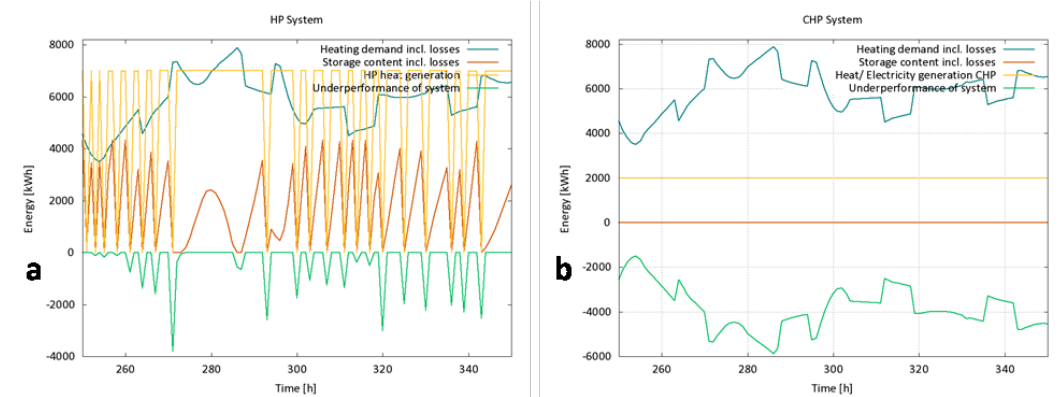
Figure 13. Analysis of the performance of both systems from the hours of the year 250 to 350, which include the peak heat demand (( a ): HP system, ( b ): CHP system). In Figure 14, 100 h in mid-October are shown for both systems. In this period, the heat demand is runs only one hour at a time, before switching off for four or more consecutive hours when the heat demand is met from the storage. Since the power of the CHP unit is lower than of the HP, less heat can be loaded into the storage in Figure 14b compared to the HP system. Also, the CHP unit must run for more than one hour at a time and is switched off for only three to four consecutive